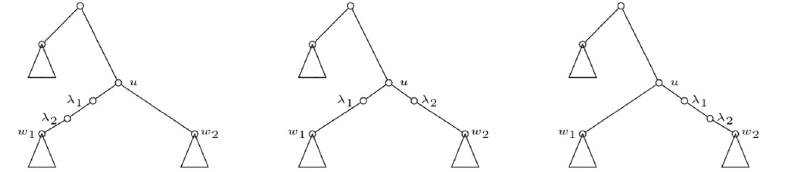
Fig 4. Non-isomorphic IMLT’s. Three non-isomorphic IMLT’s presenting the same polynomial at u